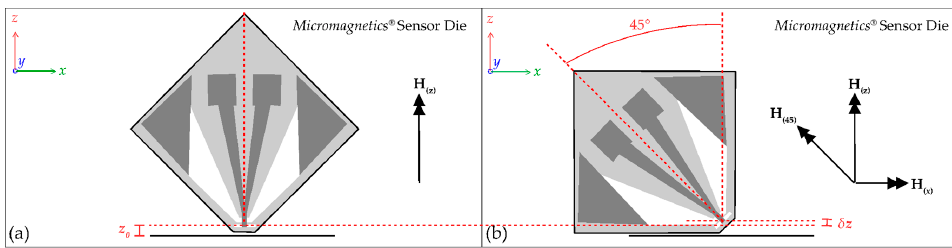
Figure 5. The geometry of the Micromagnetics ® STJ-020 TMR sensor die: ( a ) When perpendicular the minimum height of the sensor’s active area z 0 = 12 µm ± 3 µm; ( b ) At 45° to perpendicular the minimum safe approach of the sensor raises the active area by an initial estimate δ z 0 = 10 µm ± 5 µm. With a rotation of 45 ◦ counter-clockwise, the H component forms from the negative of the H ( 45 ) ( x ) component and a positive H ( z )